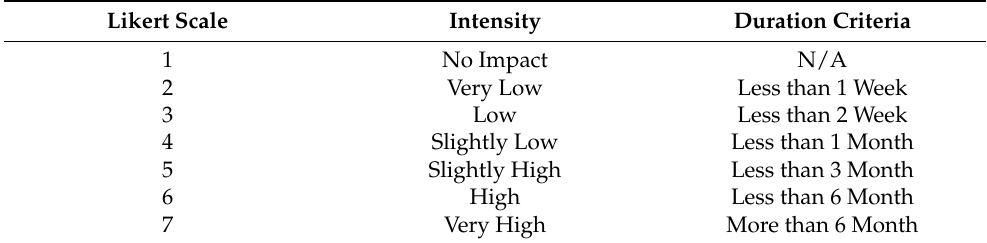
Table 3. Likert scale and duration